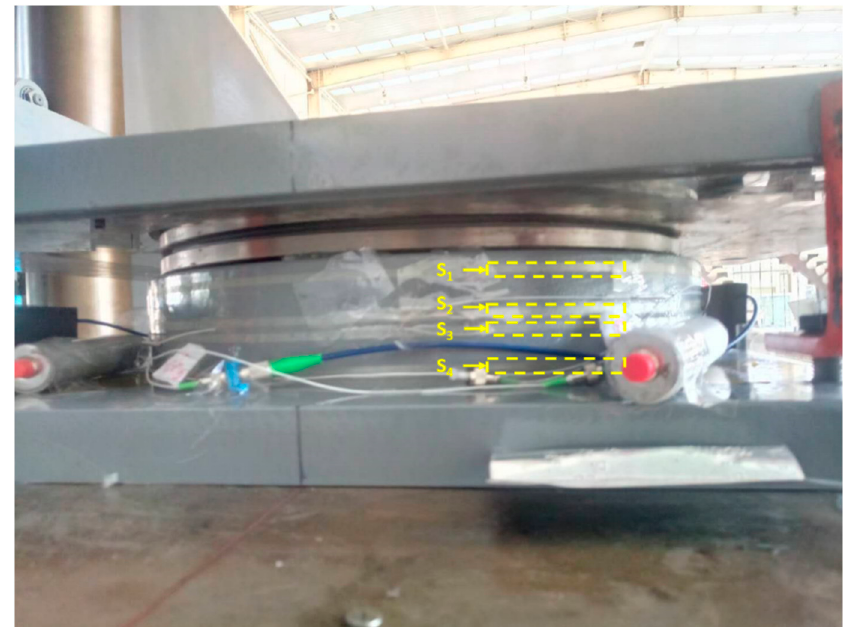
Figure 4. The picture view of load-sensitizing spherical bearing. S 1, S 2, S 3 : the three sensing fibers located at the upper region of the pot support; S 4 : the reference fiber, acting as a temperature compensation fiber.